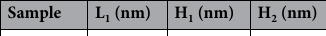
Table 2. The retrieved morphology parameters of SNTA-1, SNTA-2, and SNTA-3 from simulation.